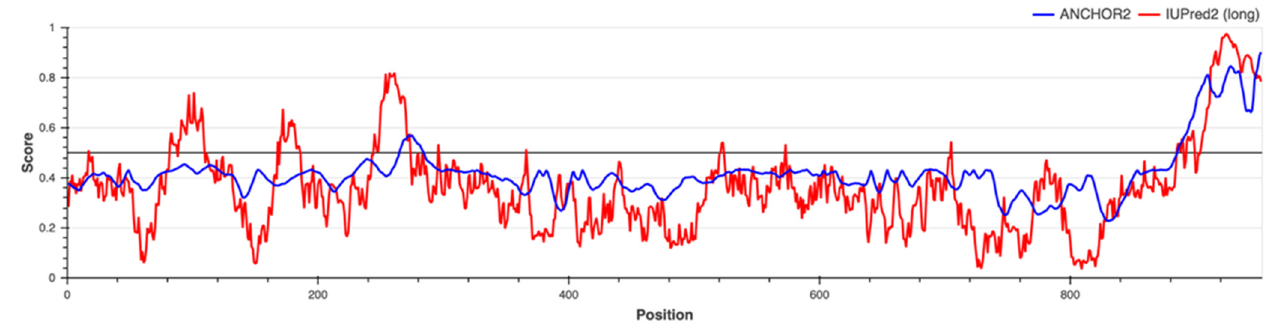
Figure 12. Protein disorder prediction for ClpK. The ClpK protein sequence (Figure S4) was analysed using the IUPred2A server for the presence of ordered and/or disordered regions. The black line represents the threshold; the red line represents the protein disorder prediction (IUPred2A), and the blue line represents the binding disorder prediction (Anchor2).